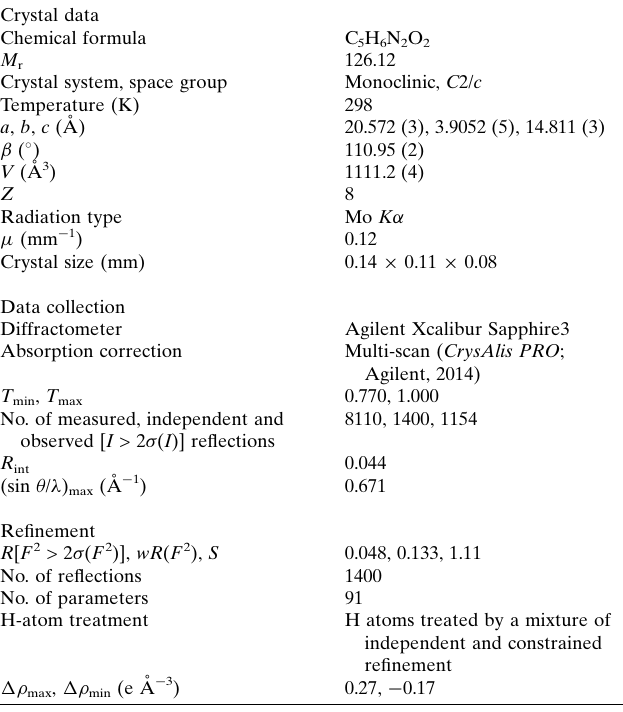
Table 2 Experimental details. Crystal data Chemical formula